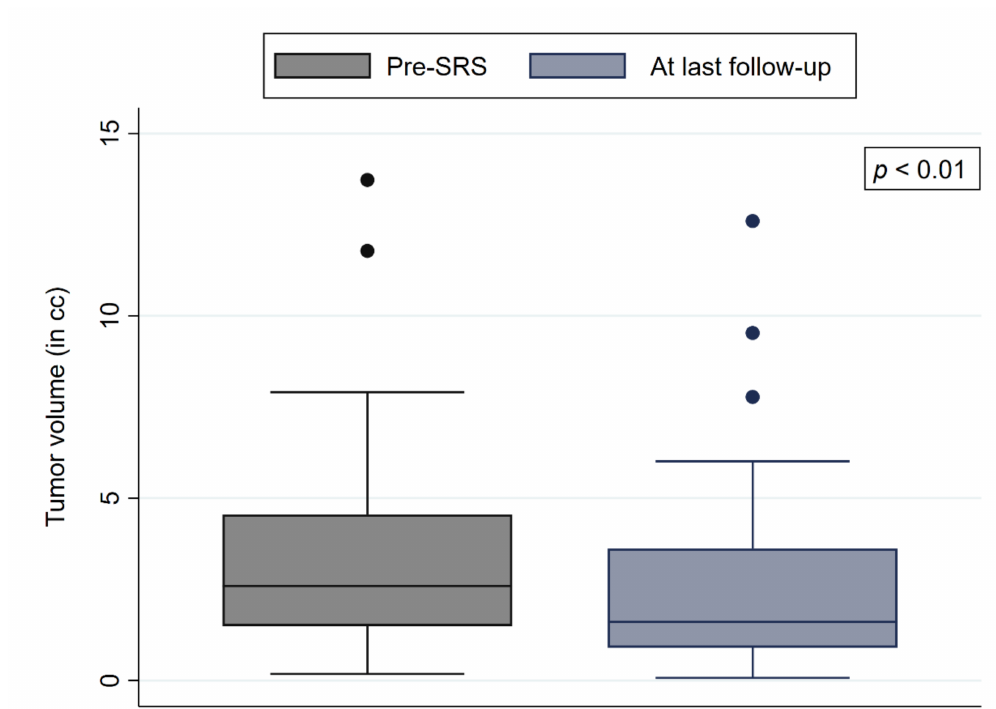
Figure 1. Box plots of the pretreatment and posttreatment tumor volumes.